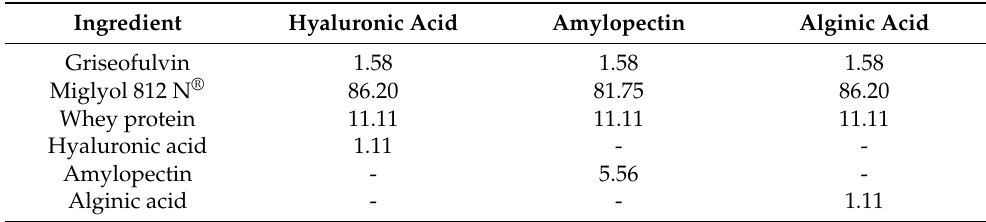
Table 2. Composition of dry emulsions as % ( w / w ). Whey protein formed the first layer in all cases followed by the